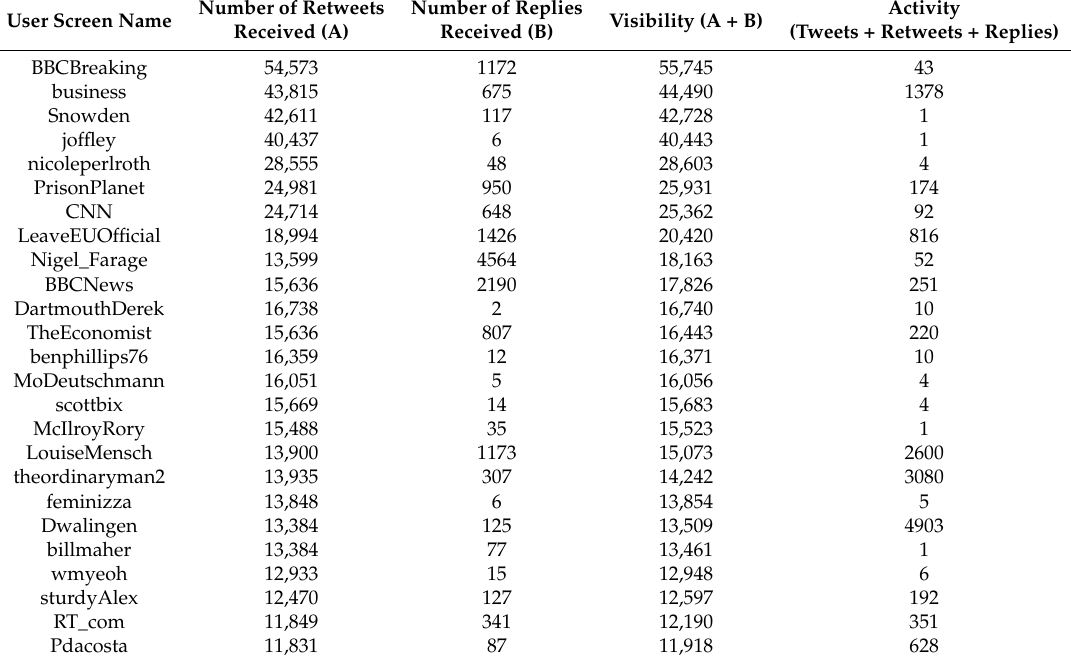
Table 1. Top 25 Visible Users and their Activity.